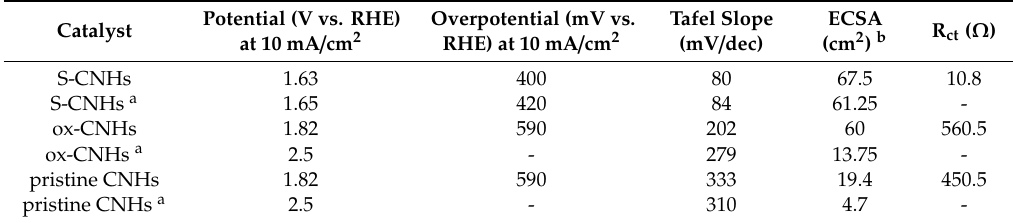
Figure 4. ( a ) LSVs, before (solid lines) and after 2000 cycles (dashed lines) for OER, ( b ) Tafel slopes, and ( c ) Nyquist plots of S-CNHs (red), ox-CNHs (black) and pristine CNHs (grey). Inset ( a ) LSVs at 10 mA / cm 2 ; ( c ) Nyquist plot for S-CNHs. The LSVs obtained at 1600 rpm rotation speed and 5 mV / s scan rate. Table 1. Electrochemical parameters for